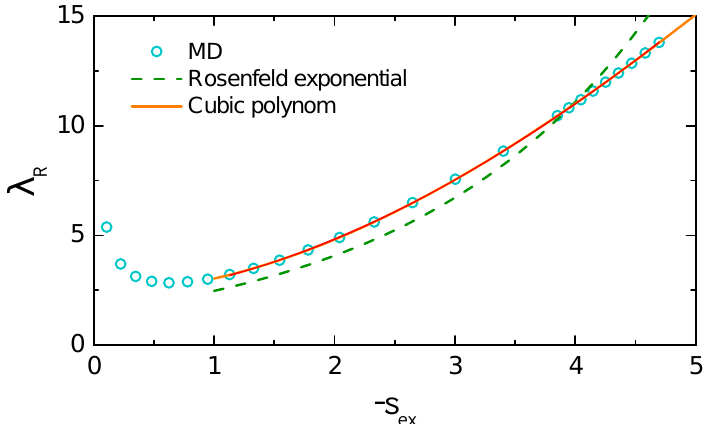
Figure 2. (Color online) Macroscopically reduced thermal conductivity coefficient λ R of the HS fluid as a function of the negative excess entropy − s ex . Symbols correspond to the numerical results from Ref. [48]. The dashed curve is the “quasi-universal” exponential scaling proposed by Rosenfeld. The solid curve is a cubic polynomial